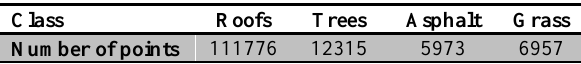
Table 1. The number of the reference points